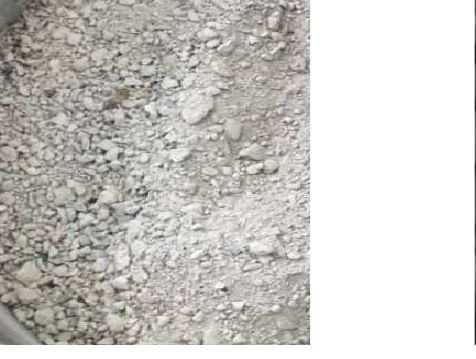
Figure 2. Fly ash ( left ) and electron micrograph ( right ).